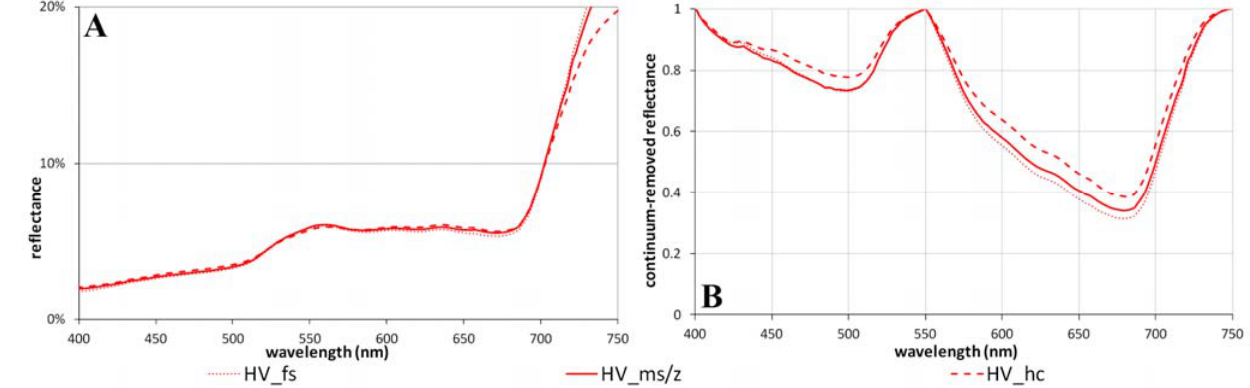
Figure 11. Spectral characteristics of the toposequence gradient at the Happy Valley study location. Comparison of ( A ) the averaged reflectance spectra in the visible (400–700 nm), and ( B ) the continuum-removed absorption features in the blue (400–550 nm) and red (550–750 nm) wavelength